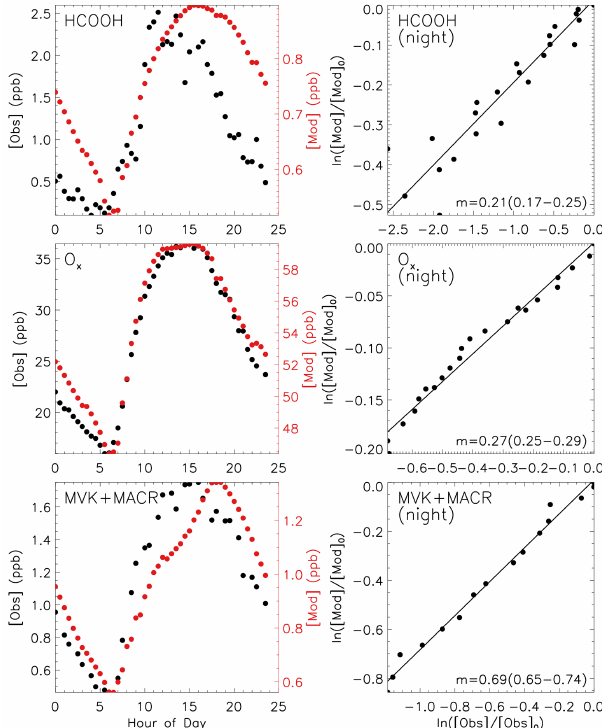
Figure 8. Nighttime measurements of HCOOH and related species over the US Southeast. Top panel: timeline of HCOOH and al- titude measurements during a SENEX flight on the night of 1– 2 July. The HCOOH trace is colored by time of day. Middle left: map of the SENEX flight track over TN and AL with the same color coding. The location of the SOAS ground site is indicated by the grey square. Also plotted (in green) is the percentage tree cover according to CLM4 (Oleson et al., 2010). Remaining pan- els: vertical profiles of HCOOH and related species as measured (black) and simulated (red) during this flight. Horizontal lines show the standard deviation of concentration in each altitude bin. Fresh biomass burning (CH 3 CN > 225ppt) and pollution (NO x / NO y > 0.4 or NO 2 > 4ppb) plumes have been removed prior to plot- ting. Separate lines are shown for the simulated abundance of MVK + MACR and MVK + MACR plus isoprene hydroxyhydroper- oxides (aka ISOPOOH), which can interfere with MVK + MACR measurements (Liu et al., 2013).